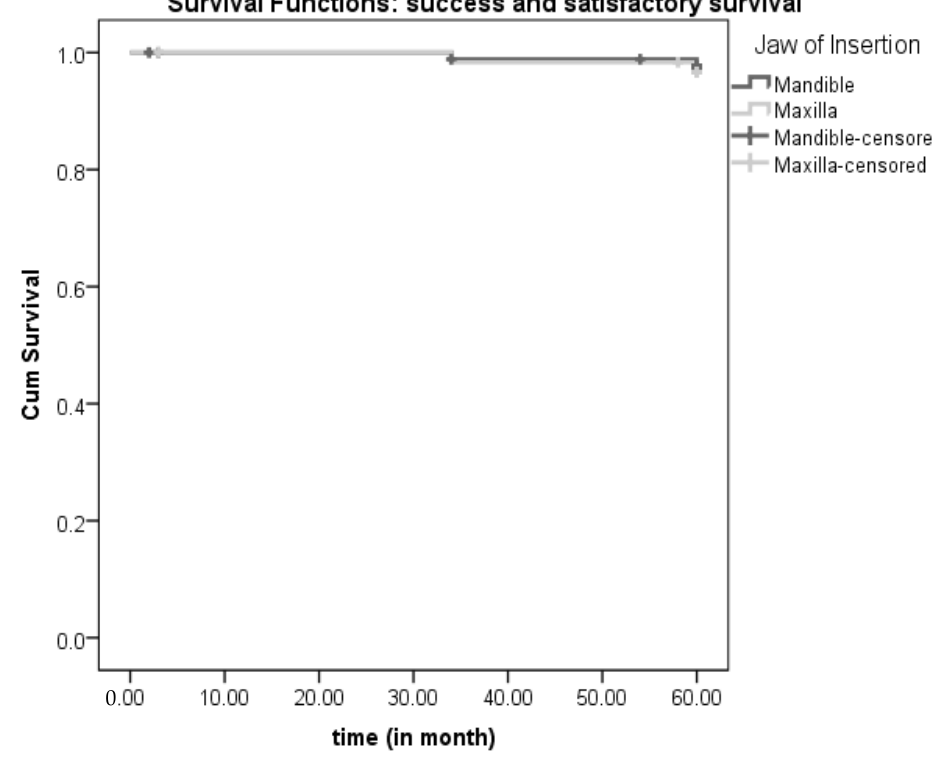
Figure 4. Kaplan Meier curves for success/satisfactory survival and failure/compromised survival over 5-years of follow-up.